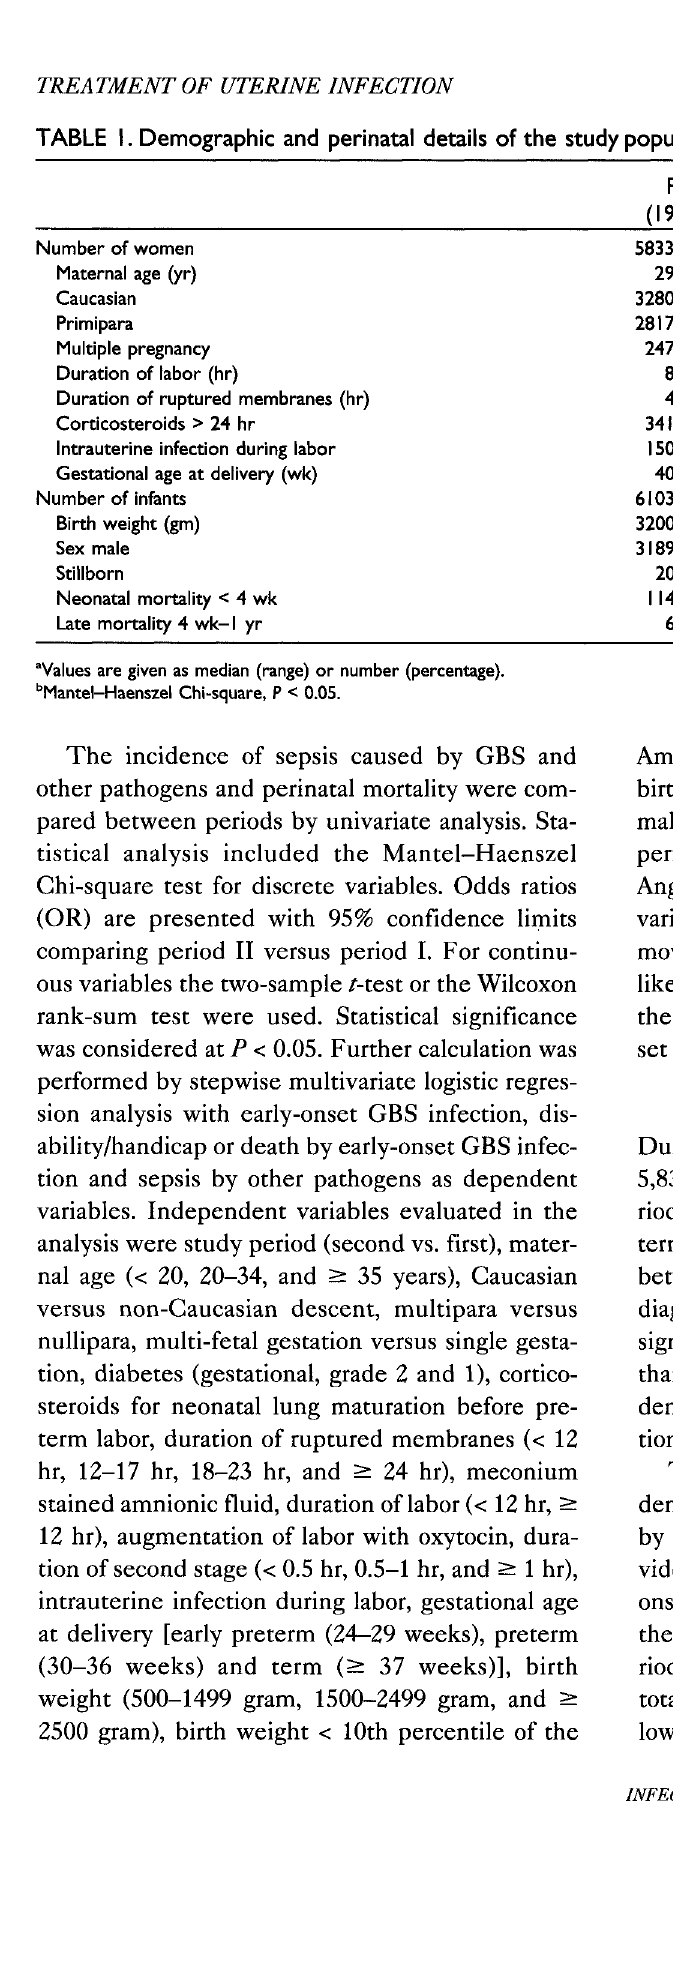
TABLE I. Demographic and perinatal details of the study